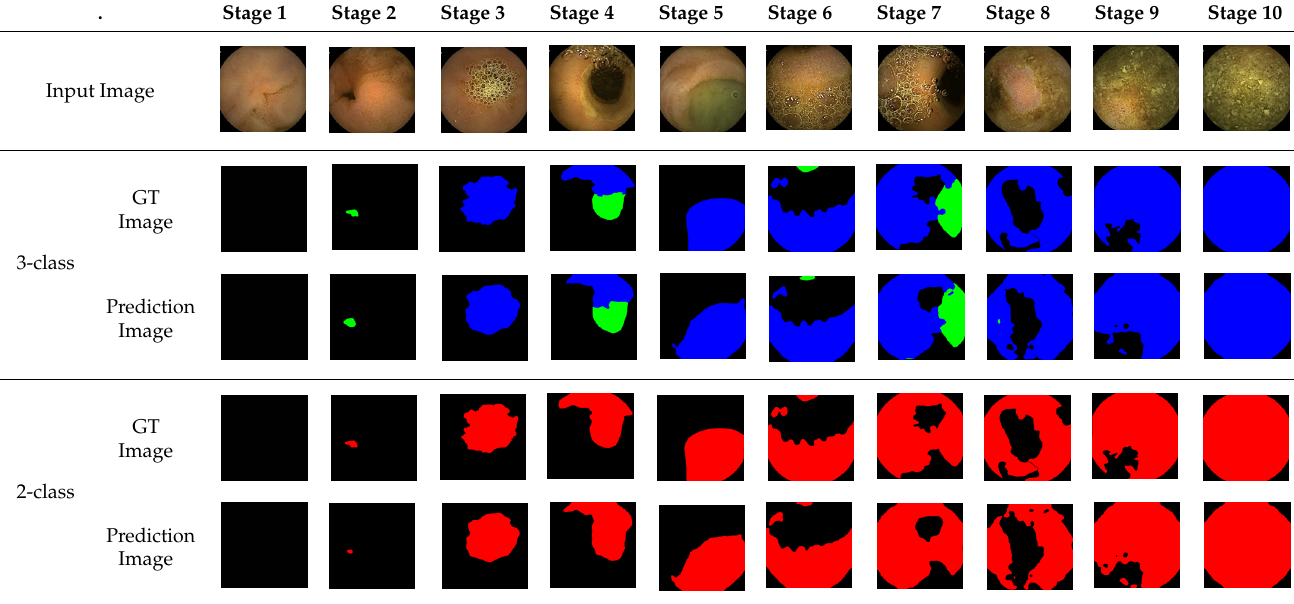
Prediction Image Black, green, blue, and red colors represent clean, dark, floats/bubbles, and non-clean regions, respectively. GT: ground truth. Black, green, blue, and red colors represent clean, dark, floats/bubbles, and non-clean regions, respectively. GT: ground Black, green, blue, and red colors represent clean, dark, floats/bubbles, and non-clean regions, respectively. GT: ground Black, green, blue, and red colors represent clean, dark, floats/bubbles, and non-clean regions, respectively. GT: ground Black, green, blue, and red colors represent clean, dark, floats/bubbles, and non-clean regions, respectively. GT: ground Black, green, blue, and red colors represent clean, dark, floats/bubbles, and non-clean regions, respectively. GT: ground Black, green, blue, and red colors represent clean, dark, floats/bubbles, and non-clean regions, respectively. GT: ground Black, green, blue, and red colors represent clean, dark, floats/bubbles, and non-clean regions, respectively. GT: ground Black, green, blue, and red colors represent clean, dark, floats/bubbles, and non-clean regions, respectively. GT: ground Black, green, blue, and red colors represent clean, dark, floats/bubbles, and non-clean regions, respectively. GT: ground Black, green, blue, and red colors represent clean, dark, floats/bubbles, and non-clean regions, respectively. GT: ground Black, green, blue, and red colors represent clean, dark, floats/bubbles, and non-clean regions, respectively. GT: ground Black, green, blue, and red colors represent clean, dark, floats/bubbles, and non-clean regions, respectively. GT: ground Black, green, blue, and red colors represent clean, dark, floats/bubbles, and non-clean regions, respectively. GT: ground Black, green, blue, and red colors represent clean, dark, floats/bubbles, and non-clean regions, respectively. GT: ground Black, green, blue, and red colors represent clean, dark, floats/bubbles, and non-clean regions, respectively. GT: ground Black, green, blue, and red colors represent clean, dark, floats/bubbles, and non-clean regions, respectively. GT: ground Black, green, blue, and red colors represent clean, dark, floats/bubbles, and non-clean regions, respectively. GT: ground Black, green, blue, and red colors represent clean, dark, floats/bubbles, and non-clean regions, respectively. GT: ground Black, green, blue, and red colors represent clean, dark, floats/bubbles, and non-clean regions, respectively. GT: ground Black, green, blue, and red colors represent clean, dark, floats/bubbles, and non-clean regions, respectively. GT: ground Black, green, blue, and red colors represent clean, dark, floats/bubbles, and non-clean regions, respectively. GT: ground Black, green, blue, and red colors represent clean, dark, floats/bubbles, and non-clean regions, respectively. GT: ground Black, green, blue, and red colors represent clean, dark, floats/bubbles, and non-clean regions, respectively. GT: ground Black, green, blue, and red colors represent clean, dark, floats/bubbles, and non-clean regions, respectively. GT: ground Black, green, blue, and red colors represent clean, dark, floats/bubbles, and non-clean regions, respectively. GT: ground Black, green, blue, and red colors represent clean, dark, floats/bubbles, and non-clean regions, respectively. GT: ground Black, green, blue, and red colors represent clean, dark, floats/bubbles, and non-clean regions, respectively. GT: ground Black, green, blue, and red colors represent clean, dark, floats/bubbles, and non-clean regions, respectively. GT: ground Black, green, blue, and red colors represent clean, dark, floats/bubbles, and non-clean regions, respectively. GT: ground Black, green, blue, and red colors represent clean, dark, floats/bubbles, and non-clean regions, respectively. GT: ground Black, green, blue, and red colors represent clean, dark, floats/bubbles, and non-clean regions, respectively. GT: ground Black, green, blue, and red colors represent clean, dark, floats/bubbles, and non-clean regions, respectively. GT: ground Black, green, blue, and red colors represent clean, dark, floats/bubbles, and non-clean regions, respectively. GT: ground Black, green, blue, and red colors represent clean, dark, floats/bubbles, and non-clean regions, respectively. GT: ground Black, green, blue, and red colors represent clean, dark, floats/bubbles, and non-clean regions, respectively. GT: ground Black, green, blue, and red colors represent clean, dark, floats/bubbles, and non-clean regions, respectively. GT: ground Black, green, blue, and red colors represent clean, dark, floats/bubbles, and non-clean regions, respectively. GT: ground Black, green, blue, and red colors represent clean, dark, floats/bubbles, and non-clean regions, respectively. GT: ground Black, green, blue, and red colors represent clean, dark, floats/bubbles, and non-clean regions, respectively. GT: ground Black, green, blue, and red colors represent clean, dark, floats/bubbles, and non-clean regions, respectively. GT: ground Black, green, blue, and red colors represent clean, dark, floats/bubbles, and non-clean regions, respectively. GT: ground Black, green, blue, and red colors represent clean, dark, floats/bubbles, and non-clean regions, respectively. GT: ground Black, green, blue, and red colors represent clean, dark, floats/bubbles, and non-clean regions, respectively. GT: ground Black, green, blue, and red colors represent clean, dark, floats/bubbles, and non-clean regions, respectively. GT: ground Black, green, blue, and red colors represent clean, dark, floats/bubbles, and non-clean regions, respectively. GT: ground Black, green, blue, and red colors represent clean, dark, floats/bubbles, and non-clean regions, respectively. GT: ground Black, green, blue, and red colors represent clean, dark, floats/bubbles, and non-clean regions, respectively. GT: ground Black, green, blue, and red colors represent clean, dark, floats/bubbles, and non-clean regions, respectively. GT: ground Black, green, blue, and red colors represent clean, dark, floats/bubbles, and non-clean regions, respectively. GT: ground truth. truth. truth. truth. truth. truth. truth. truth. truth. truth. truth. truth. truth. truth. truth. truth. truth. truth. truth. truth. truth. truth. truth. truth. truth. truth. truth. truth. truth. truth. truth. truth. truth. truth. truth. truth. truth. truth. truth. truth. truth. truth. truth. truth. truth. truth. truth. truth. truth. truth.